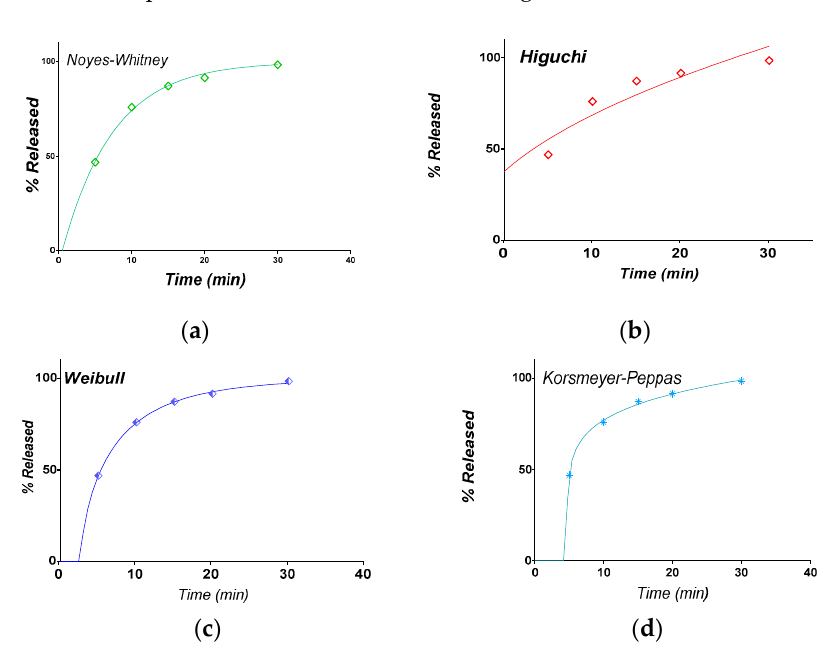
Figure 12. Comparative assessment of the in vitro release profiles of captopril from the orally disintegrating tablets containing the CAP- β -CD inclusion complex in simulated saliva (red) and 0.01 N (green) HCl, respectively.